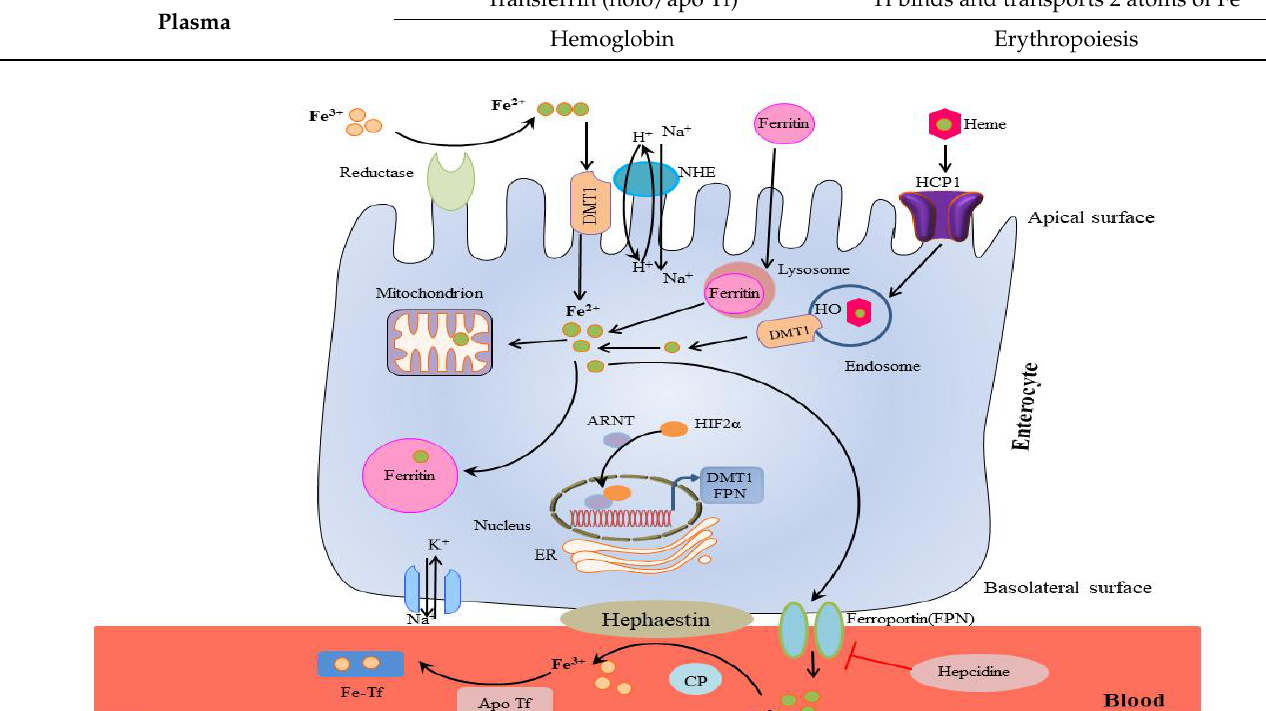
Figure 1. Iron absorption through the enterocyte. Reductases reduced Fe 3+ before entering in the